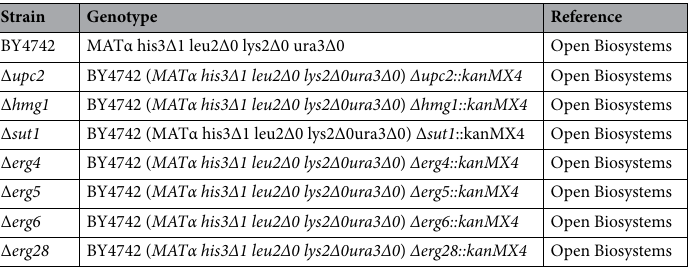
Table 1. Genotypes S. cerevisiae wild-type and deletion mutant strains used in this